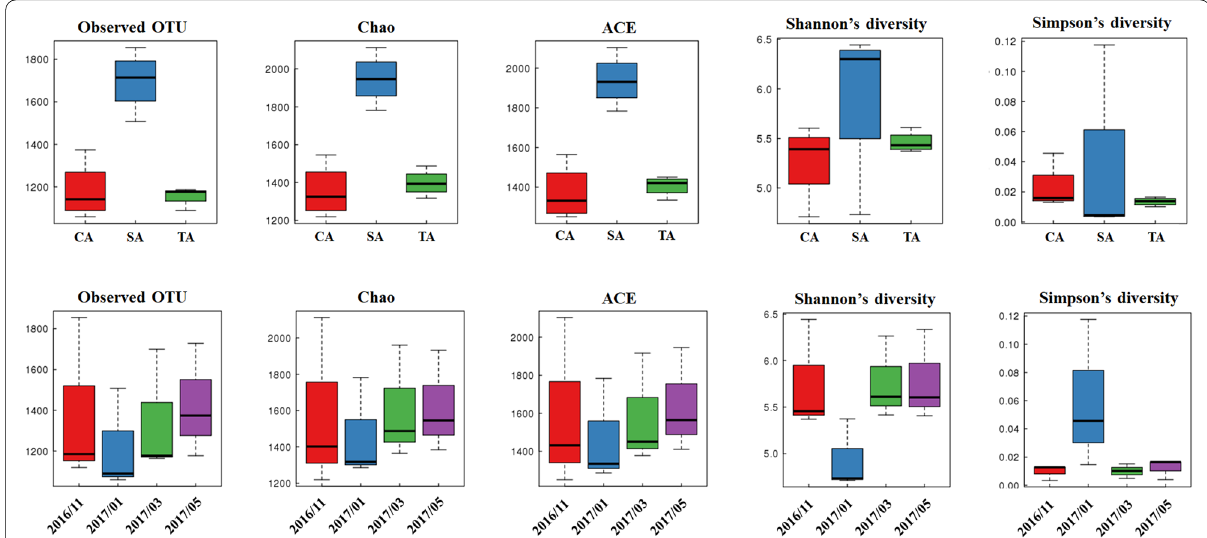
Fig. 7 Alpha diversity of the soil bacteria in the tea plantations. The alpha diversity including observed OTU, Chao, ACE, Shannon, and Simpson from CA, TA, and SA soils between November 2016 and May 2017 are given. The indices are calculated by Mothur (v1.31.2) and implemented by the R software